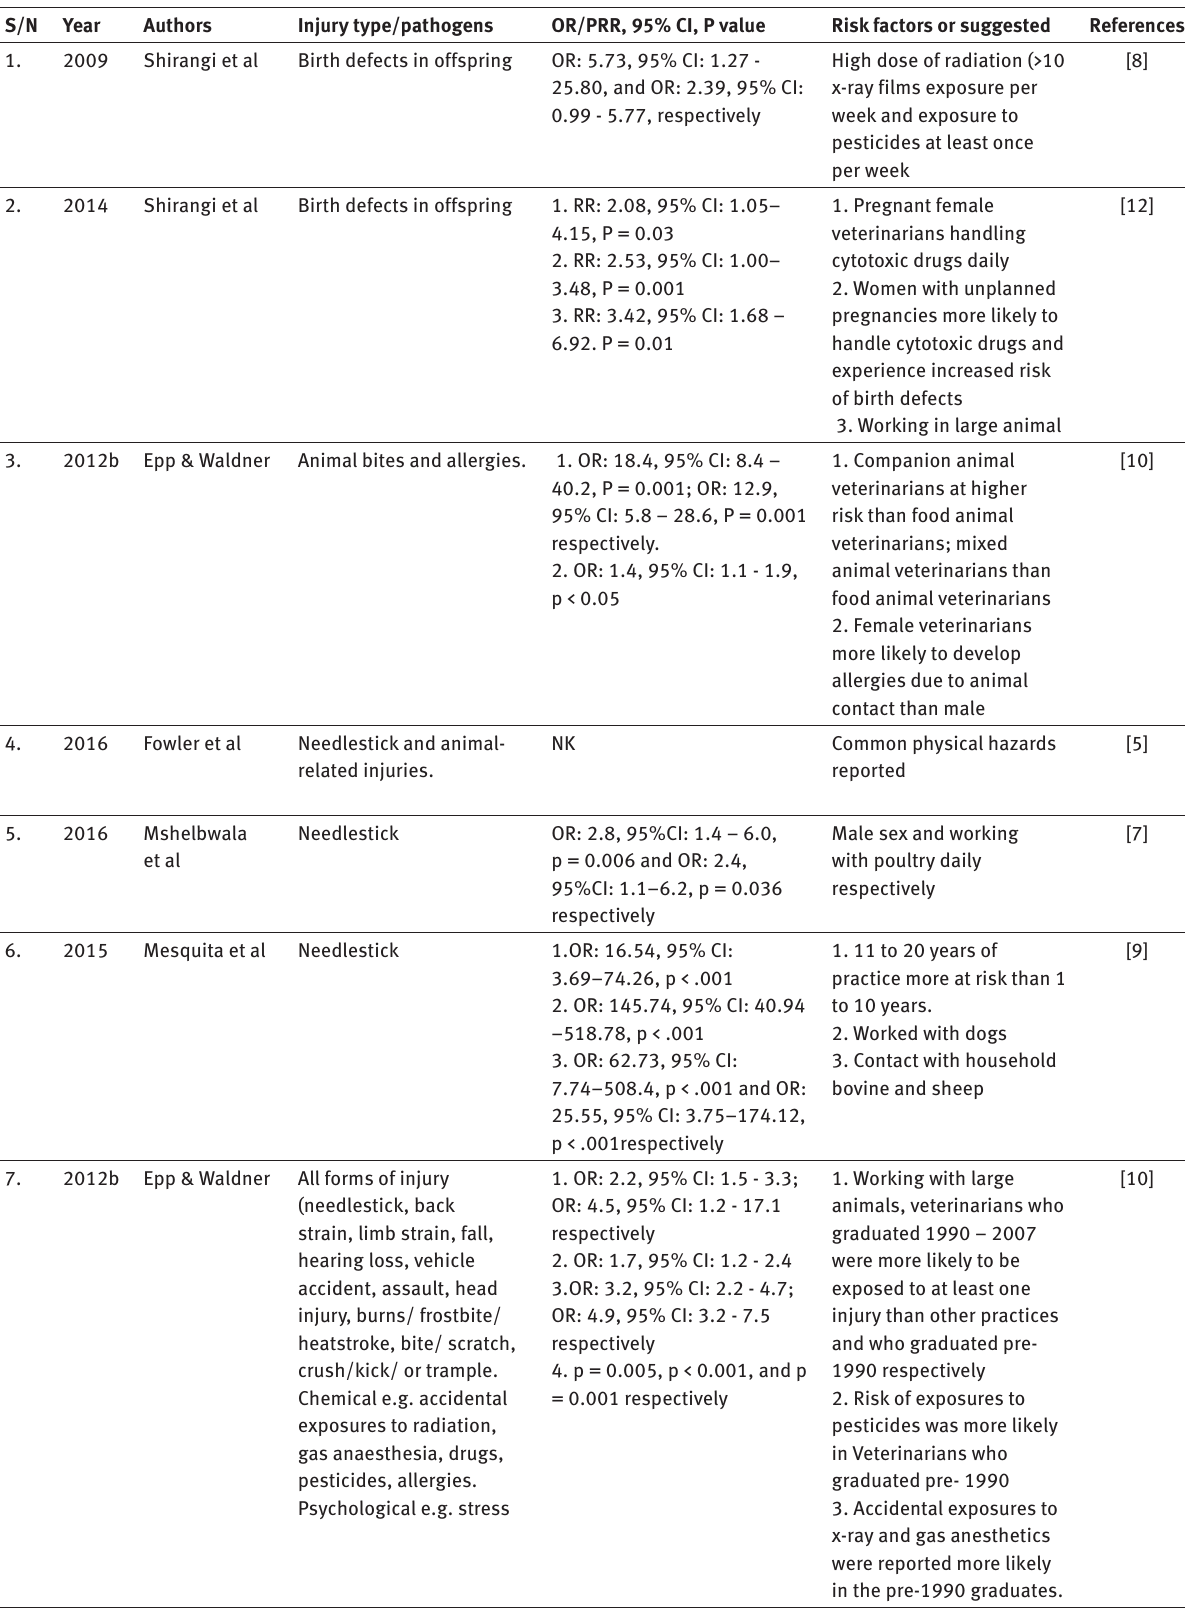
Table 2 A description of all physical and chemical hazards identified in the systematic reviews and the associated risk